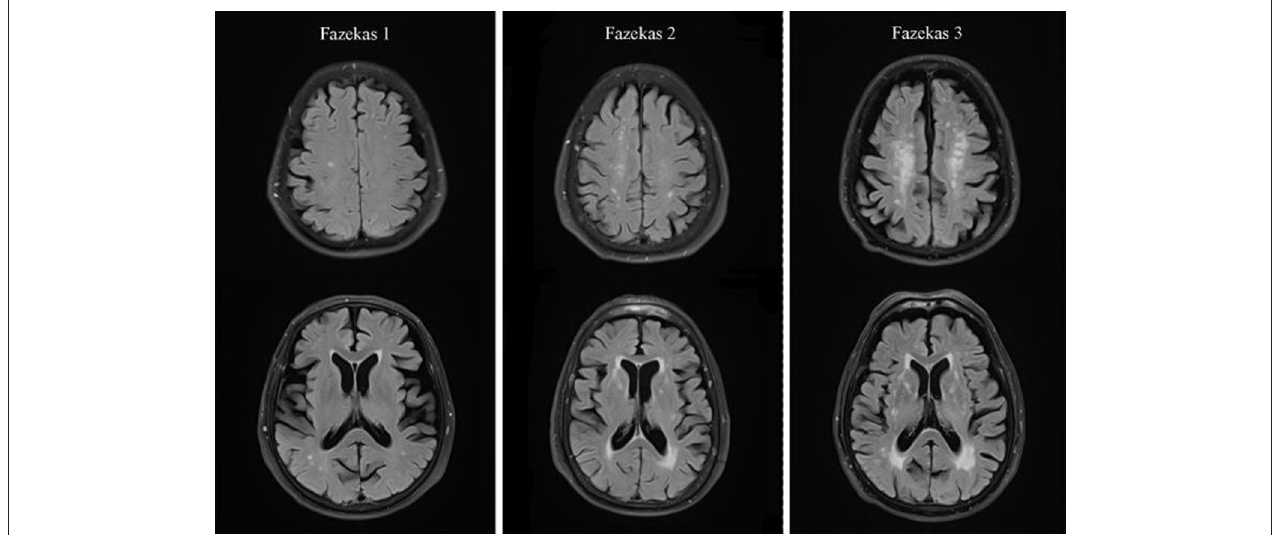
FIGURE 2 | Representative T2-FLAIR images illustrating Fazekas score.